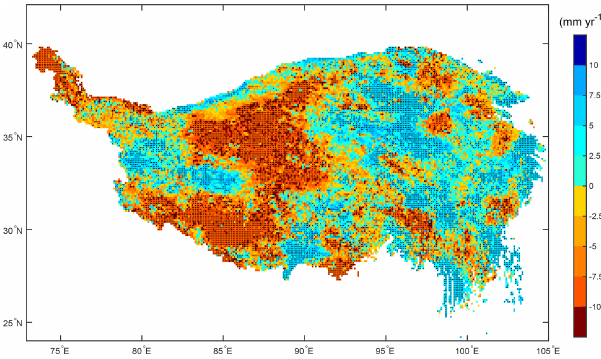
Figure 5. Spatial distribution of annual ET a linear trend on the TP from 2001 to 2018. The stippling indicates the trends that pass the t test ( p < 0 .